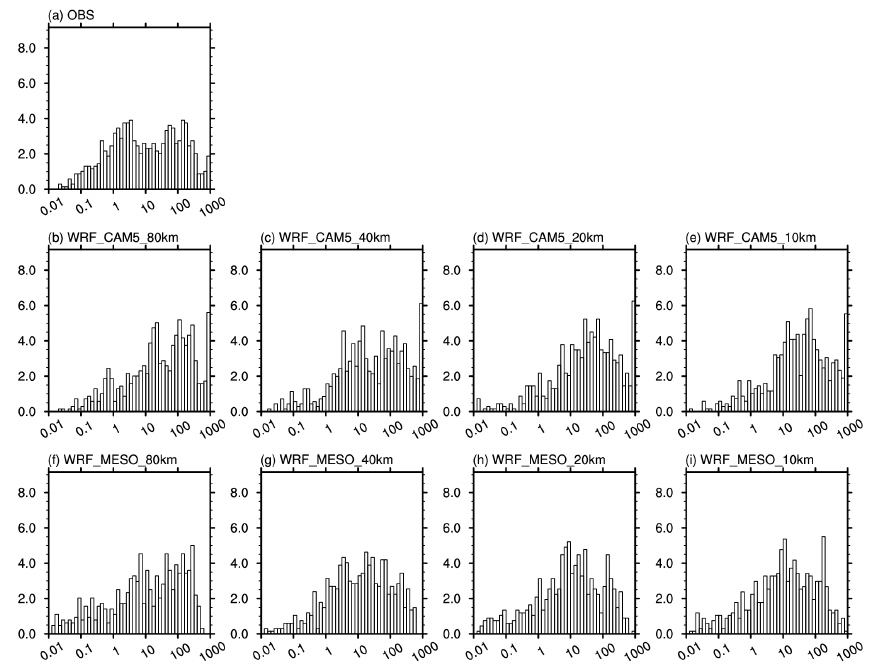
Fig. 18. Histograms (percentage) of (a) the observed ice water path (gm − 2 ) from ARM Cloud Retrieval Ensemble Dataset, and (b) – (i) the simulated in-cloud ice water path (gm − 2 ) from (b) – (e) WRF_CAM5 and (f) – (i) WRF_MESO simulations at Barrow.